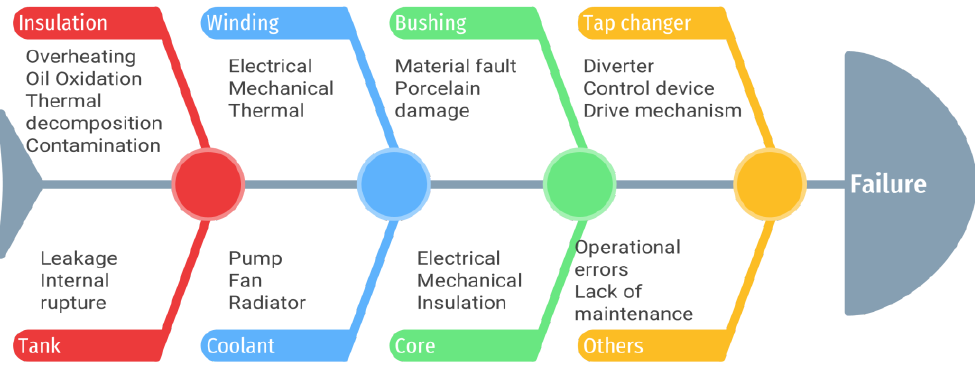
Figure 3. ISHIKAWA diagram of power transformer failures.